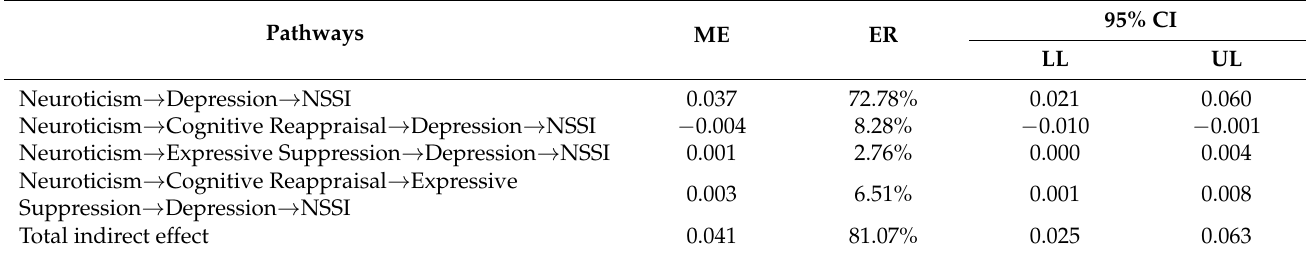
Table 3. Mediation effect analysis of neuroticism, emotion regulation, depression, and NSSI.